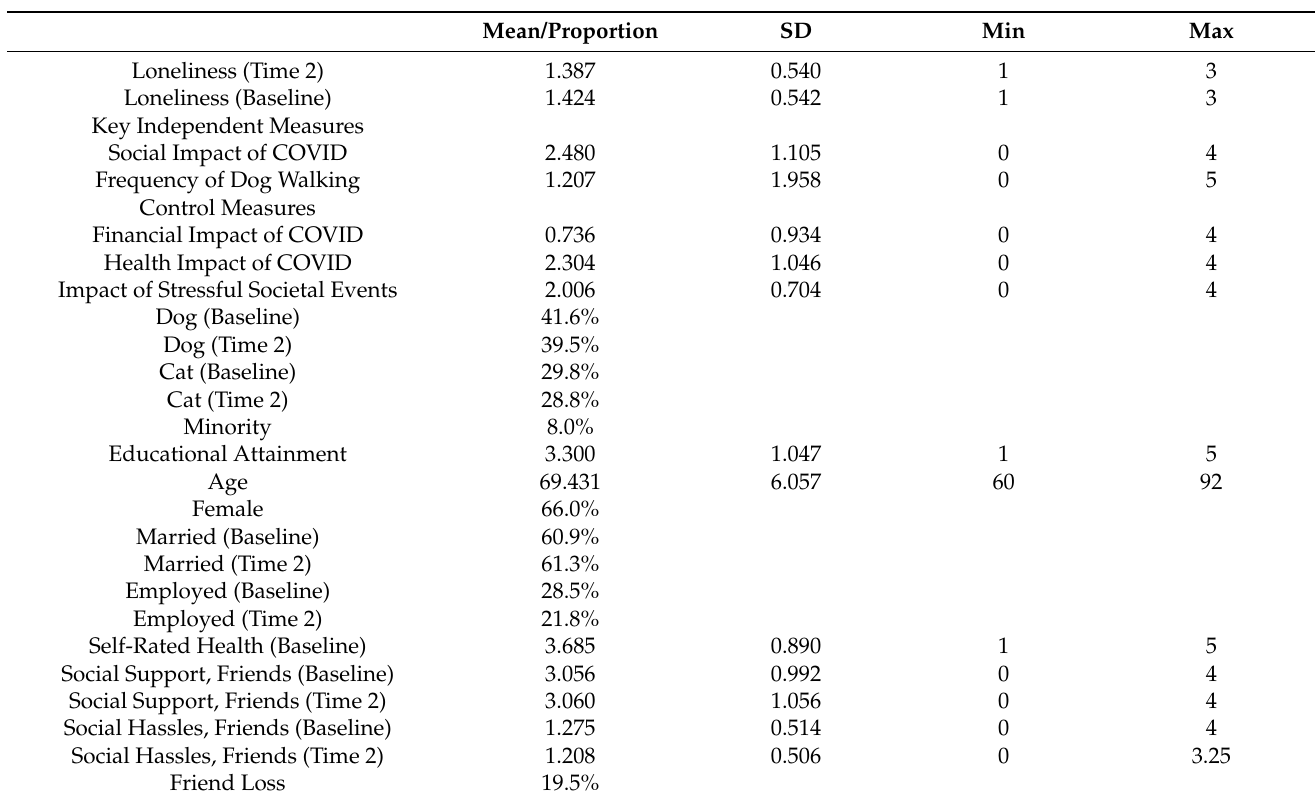
Table 1. Characteristics of Study Sample (N =